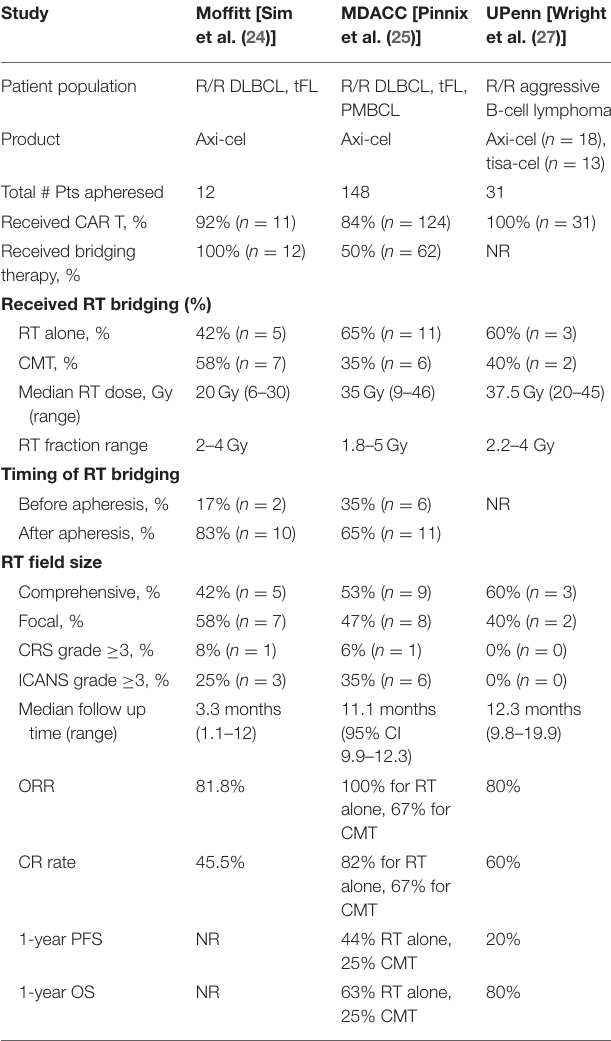
TABLE 1 | Characteristics and results of initial reports of radiation therapy as bridging treatment prior to CD-19 CAR T-cell therapy among non-Hodgkin lymphoma